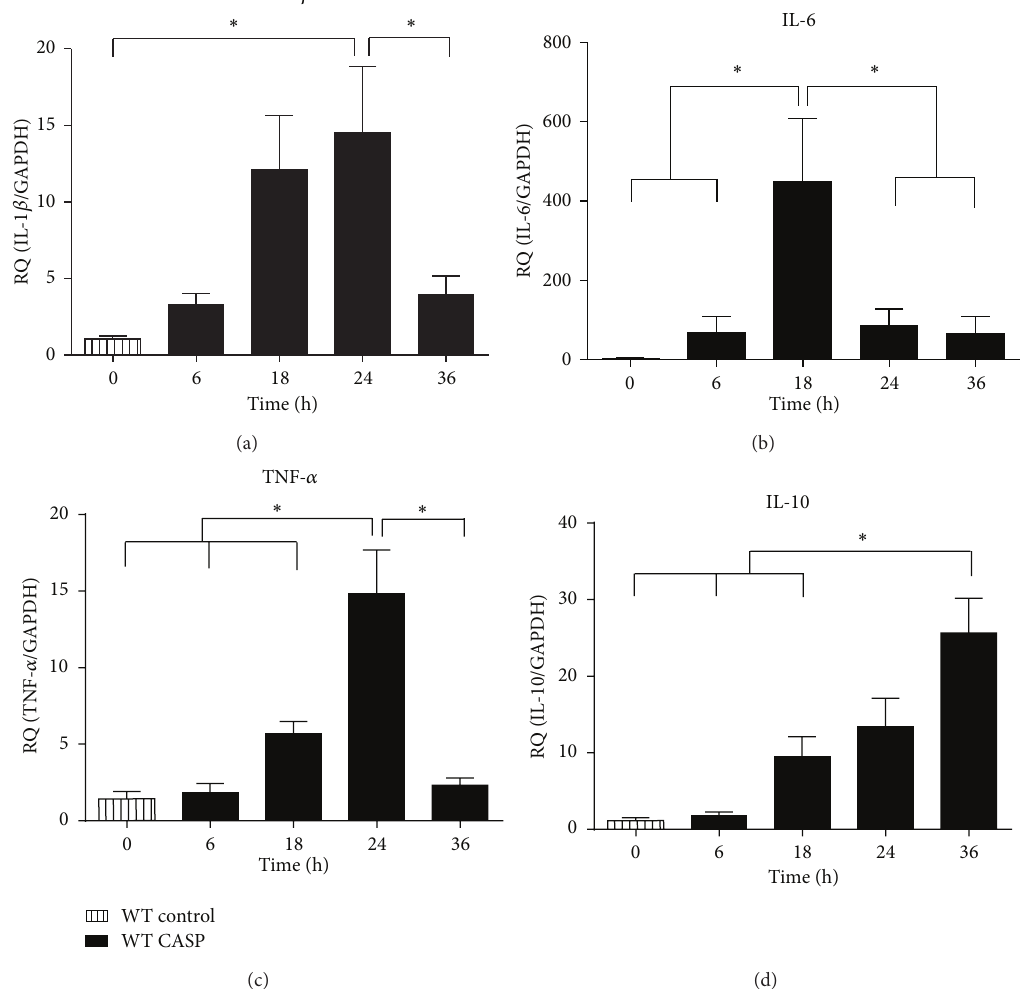
Figure 2: Cardiac inflammation profile. (a)–(d) Messenger RNA levels of pro- and anti-inflammatory cytokines obtained from WT mice hearts 6, 18, 24, and 36 hours after CASP surgery. Untreated WT mice served as control group ( ∗ : 𝑃 < 0.05 ; 𝑛 = 10/ group; mean ± SEM).